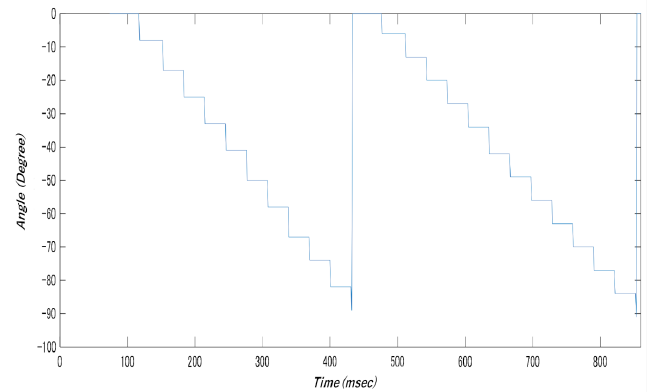
Figure 9. Attitude control test results (left-hand rotation).